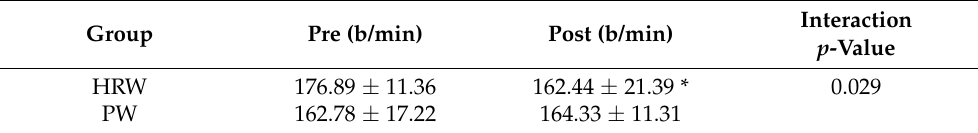
Table 3. Maximum heart rate before and after the intervention within the HRW and PW